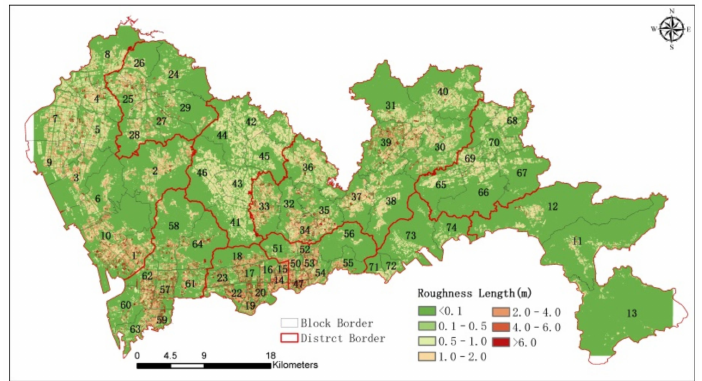
Figure 12. Roughness length distribution in Shenzhen.